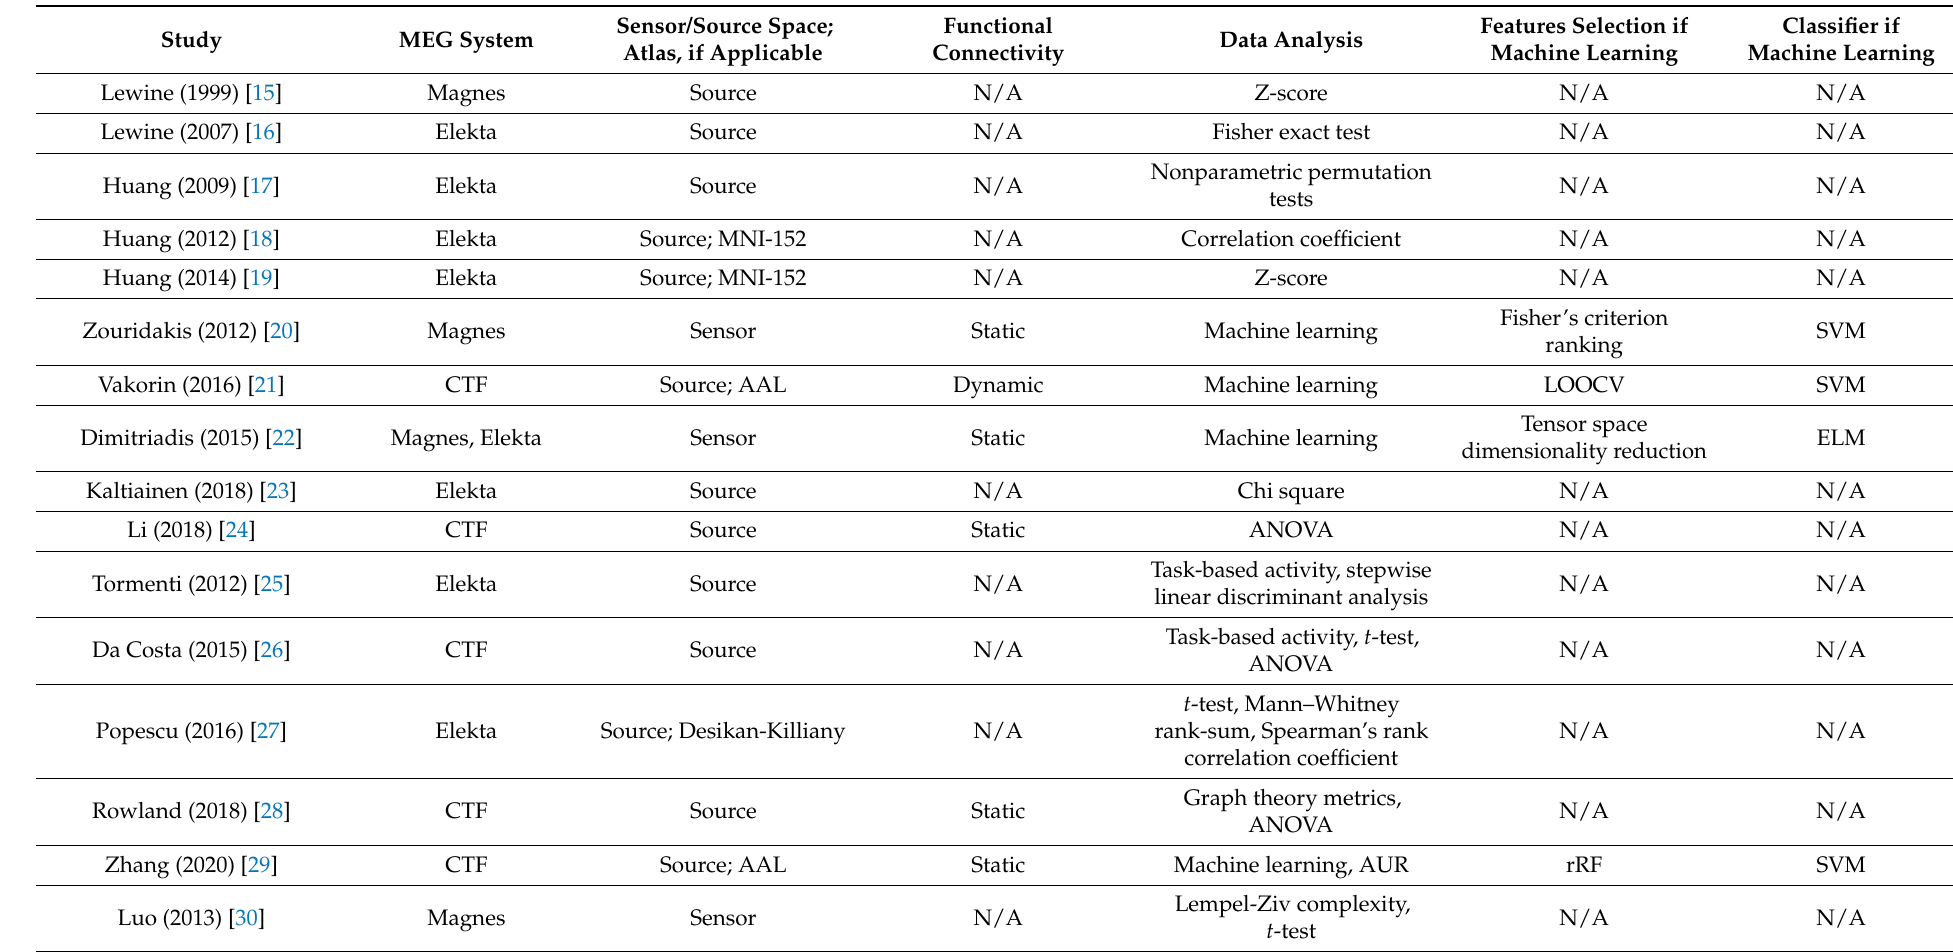
Table 2. Magnetoencephalography system and data analysis details for each study, listed in the order referenced. MNI = Montreal Neurological Institute; SVM = support vector machine; CTF = CTF MEG International Services; ELM = extreme learning machine; ANOVA = analysis of variance; AAL = Automated Anatomical Labelling atlas; LOOCV = leave-one-out cross-validation; AUR = area under receiver operating characteristic curve; rRF = recursive random forests; k-NN = k nearest neighbors; ENS = ensemble classification; AEC = amplitude envelope